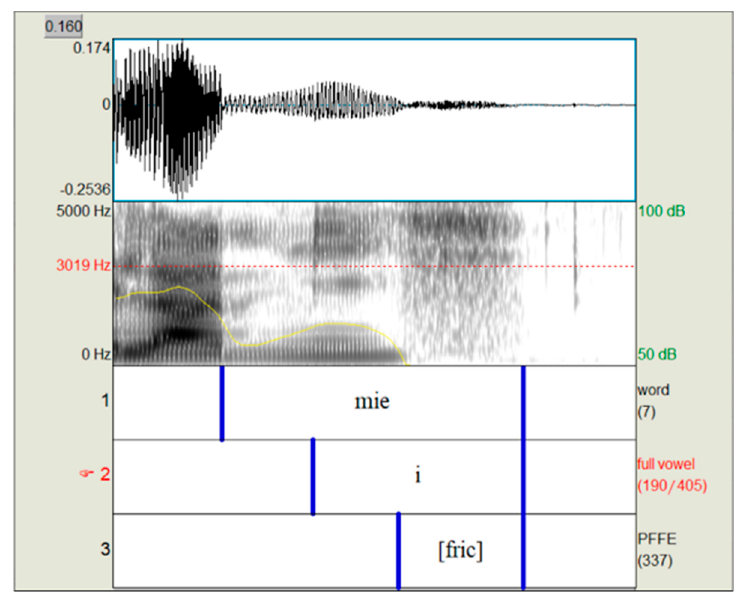
Figure 2. The segmentation of mie ‘crumb.’ With a full-vowel length of 287 ms and a fricative length of 171 ms, the FVR of this token is 59.6%.